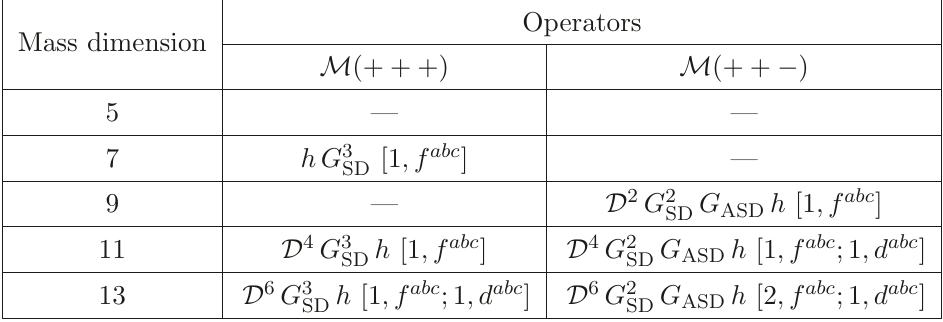
3 g amplitude. The number of independent operators →